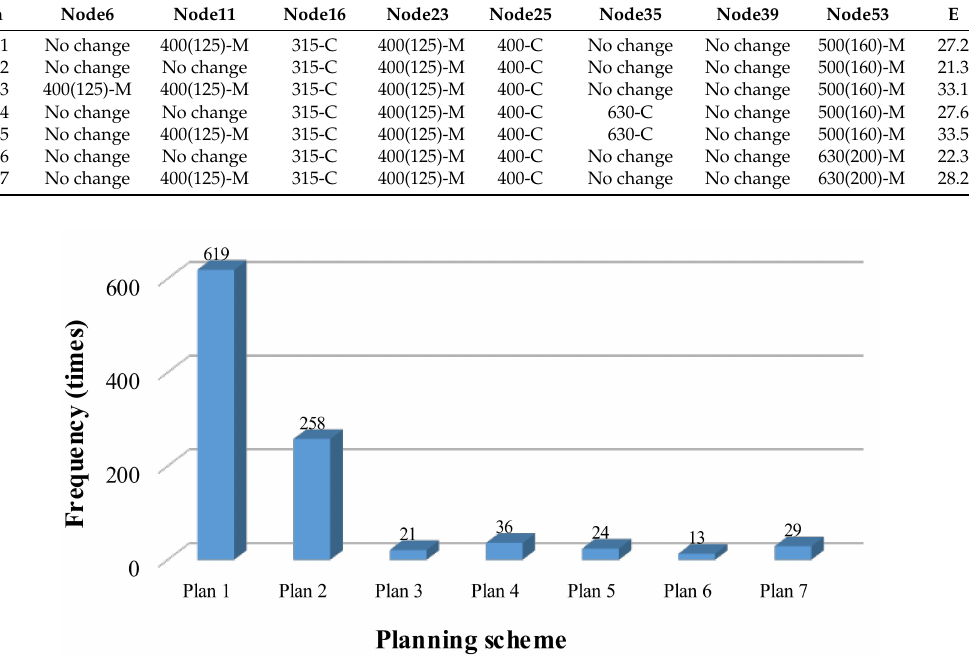
Figure 8. Frequencies of seven planning schemes with nodal effective load considering